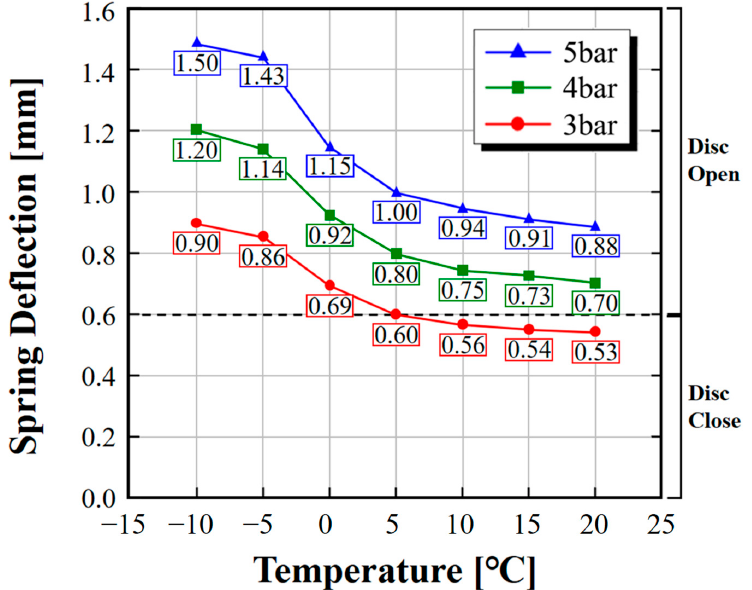
Figure 8. Spring deflection values according to temperature changes and water pressure levels.